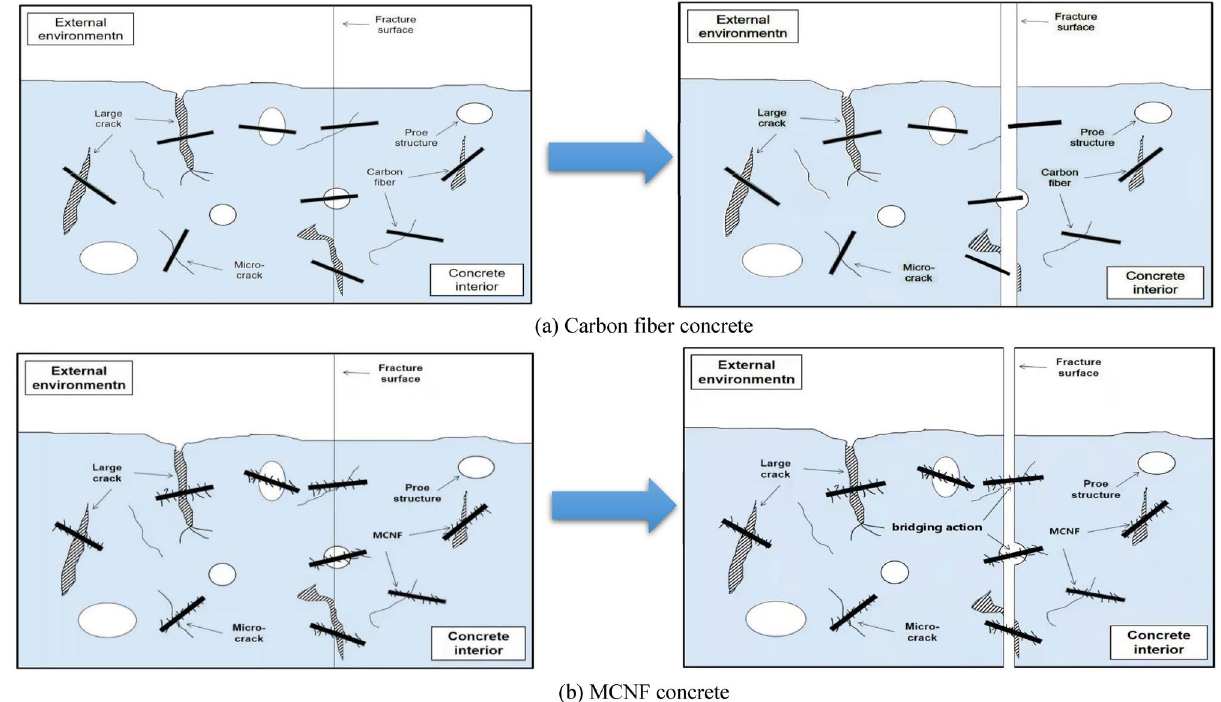
Figure 12. Schematic diagram of failure mechanism of carbon fiber concrete and MCNF